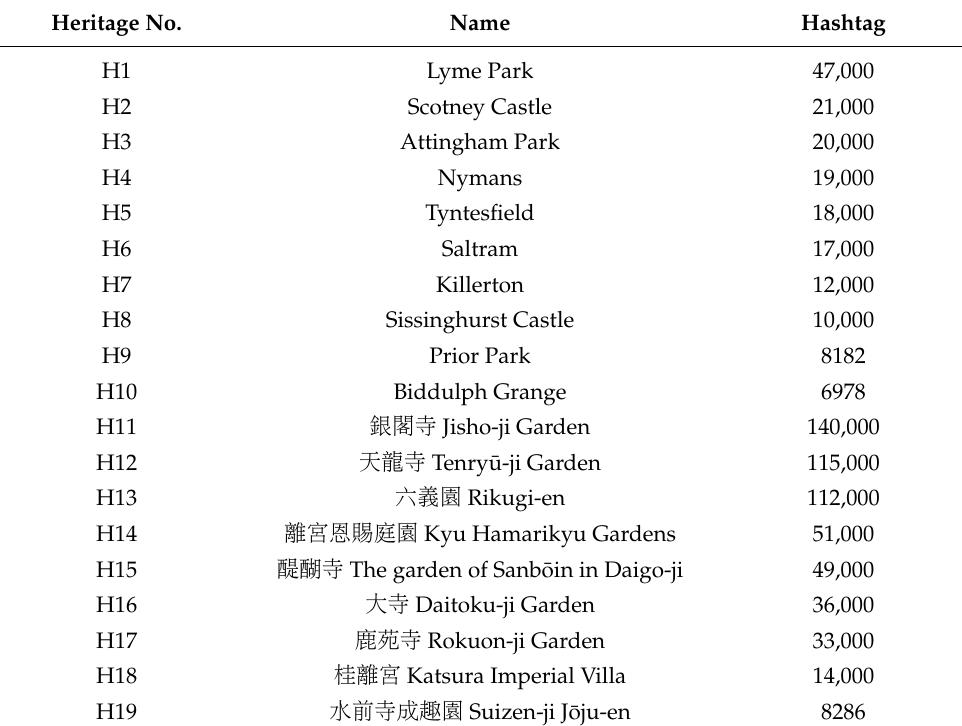
Table 1. Selected heritage landscape with the corresponding hashtag data (assessed from Instagram in 4 October